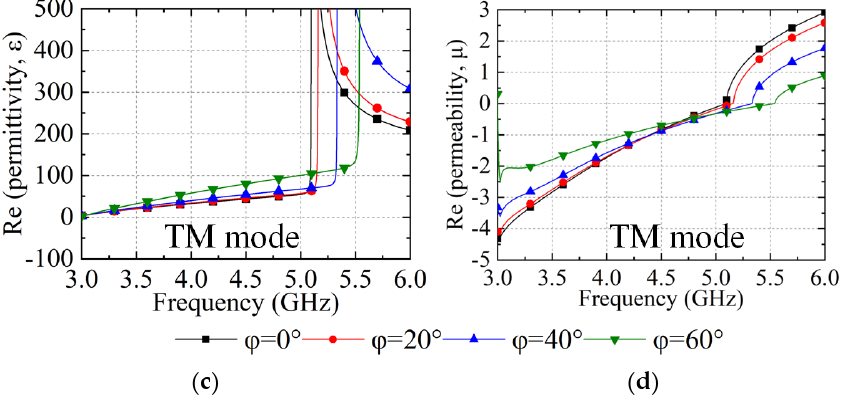
Figure 3. NRMS unit cell with incident angle along the tangent direction of the surface: ( a ) the simulation model, ( b ) the S-parameters, ( c ) the real part of the permittivity in different incident angles, and ( d ) the real part of the permeability in different incident angles.